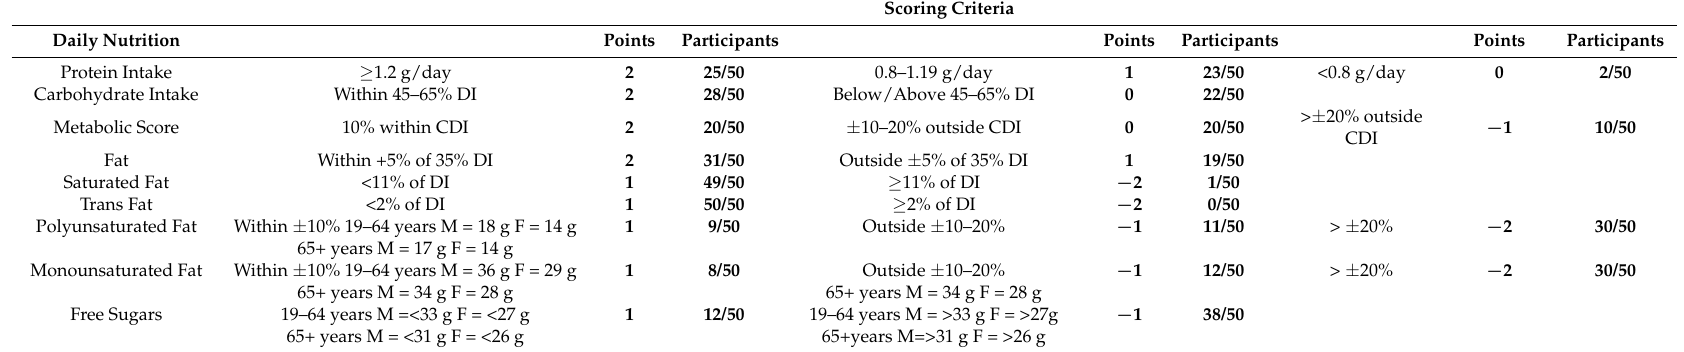
Table A2. Participant scoring and criteria utilized for participants’ habitual daily nutritional intake and nutrients positively associated with bone